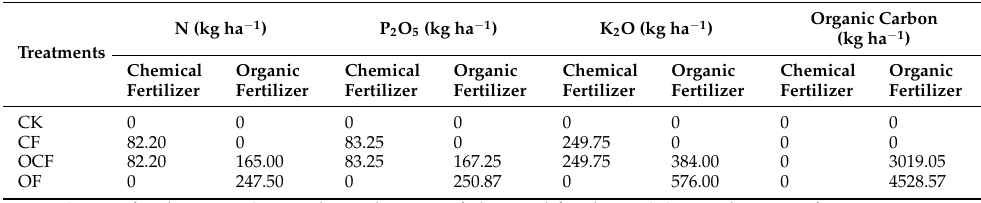
Table 1. Nutrient application rate of different